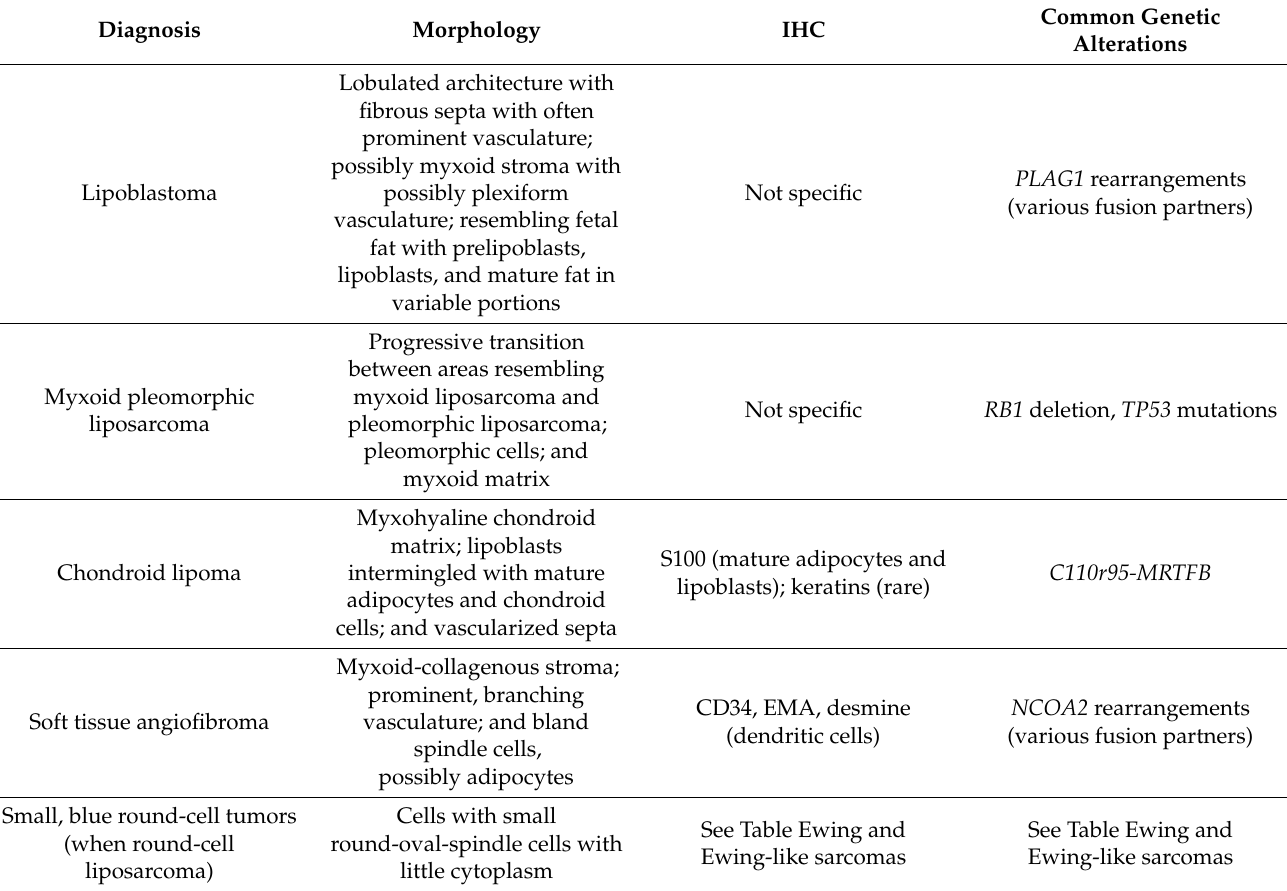
Figure 5. Myxoid liposarcoma showing different stages of primitive fat cells. There is slight pleomor- phism. The myxoid matrix contains variable collagen (HE; 20 × magnification). Table 4. Differential diagnoses of